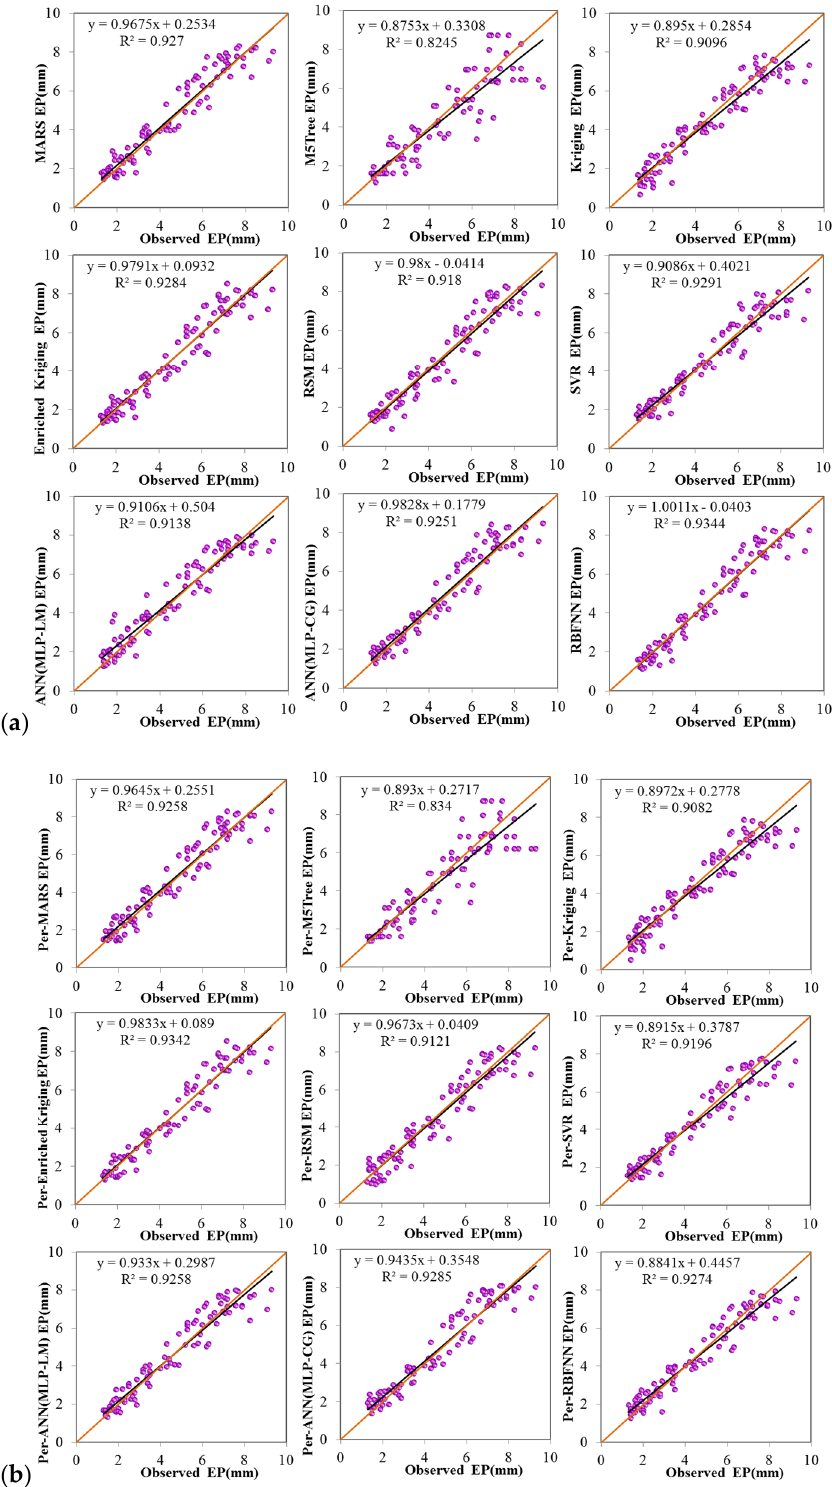
Figure 7. The observed and estimated EP ( a ) without and ( b ) with periodicity for Antakya Station in the testing period.